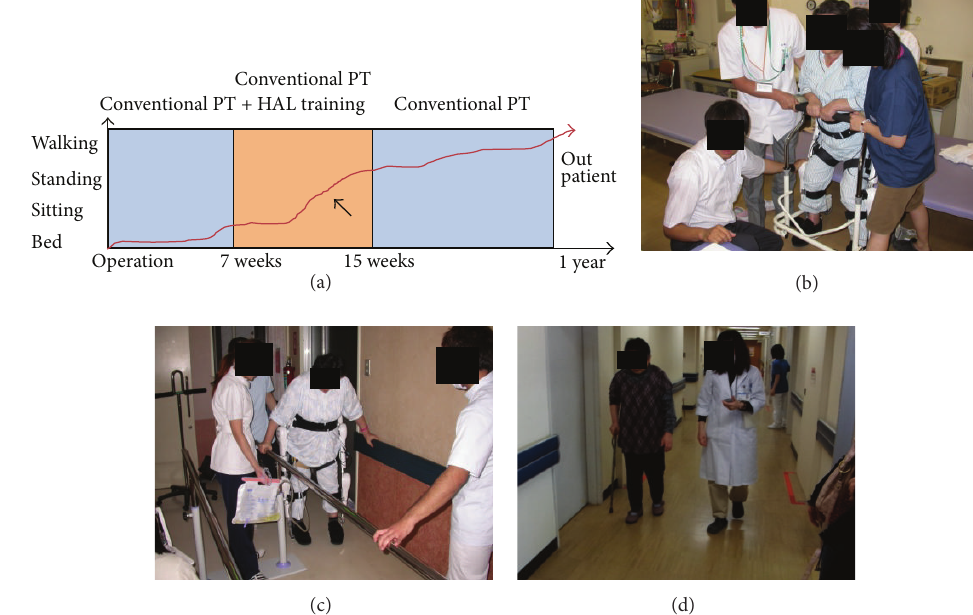
Figure 3: Improvement time course of activity of the patient in a schematic view (a). Although she underwent conventional physical therapy (PT), she was still bedridden 7 weeks after surgery. Locomotor functions of the patient improved considerably by intervention of the robot suit hybrid assistive limb (HAL) training. Subsequently, the walking ability recovered rapidly (arrow). When she put on the HAL at baseline, she could stand for only few seconds with assistance from three tree therapists (b). However, she could walk in the parallel bars at 12 weeks after surgery (c) and could walk independently 1 year after surgery (d).